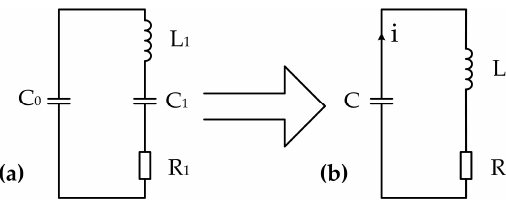
Figure 4. Equivalent circuits of the transducer: ( a ) general form; and ( b ) series-resonant form.